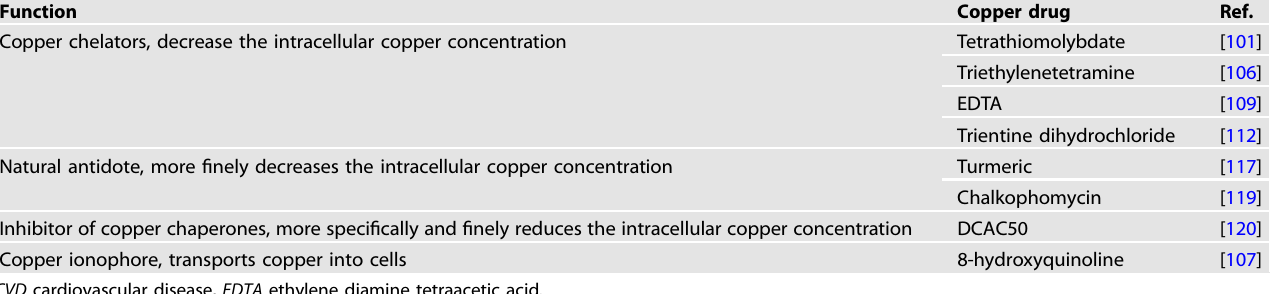
Table 3. Potential therapies regulating copper in cuproptosis-related CVD. Function Copper drug